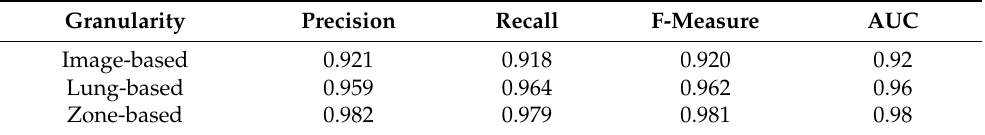
Table 2. Performance evaluation of ChexNet features with varying feature extraction